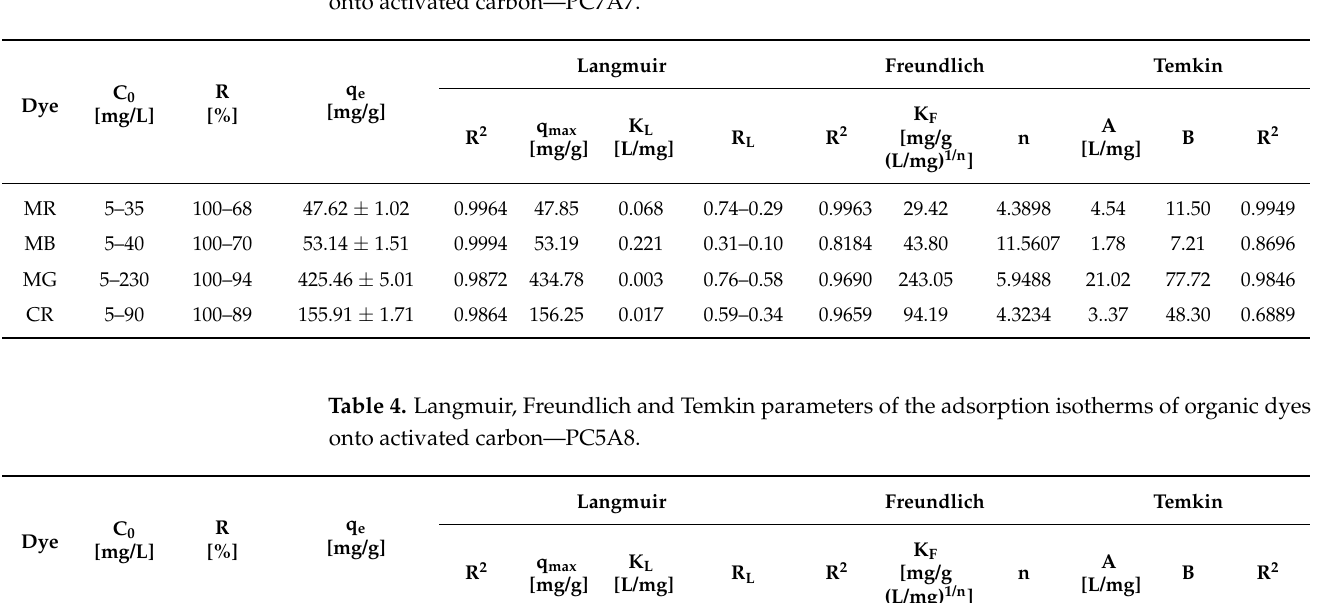
Table 3. Langmuir, Freundlich and Temkin parameters of the adsorption isotherms of organic dyes onto activated carbon—PC7A7.